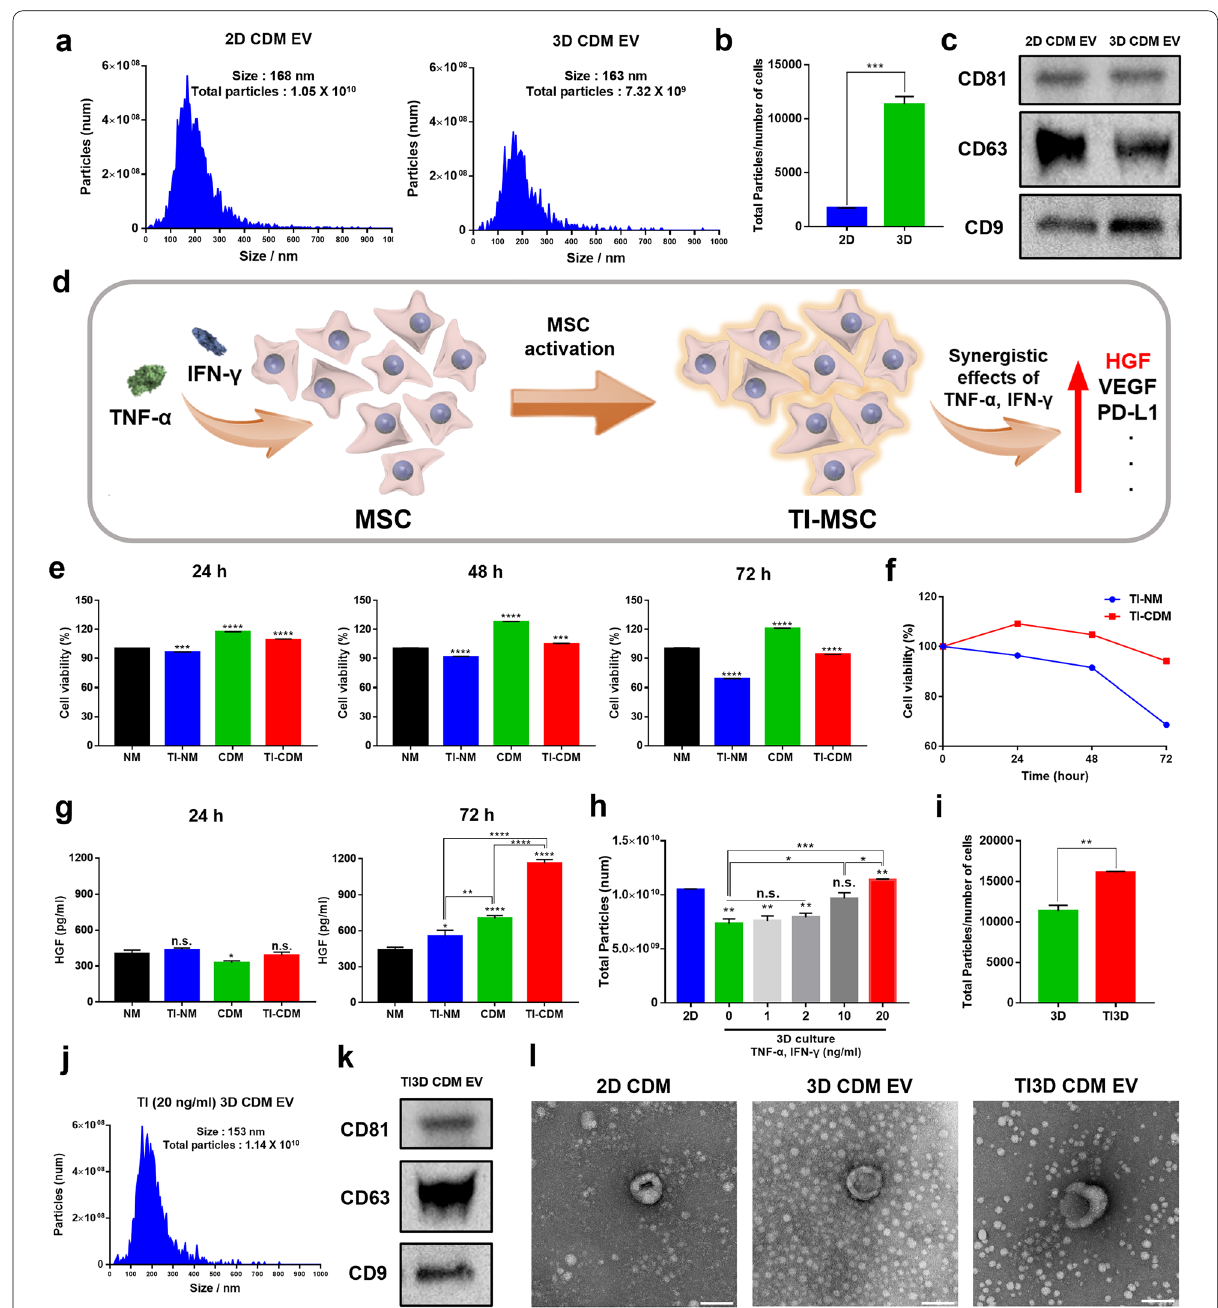
Fig. 2 Characterizations of EV from three different culture conditions. a ZetaView ® analysis for the size and number of total particles of 2D CDM EV and 3D CDM EV. b The number of particles per cell for 2D CDM EV and 3D CDM EV. c The Western blot analysis of 2D CDM EV and 3D CDM EV for representative surface markers of EVs. d The benefits of MSC activation using TNF‑α and IFN‑γ (TI) priming. e Time‑dependent cell viability with TI activation in NM and CDM (NM; Normal media, 10% fetal bovine serum supplemented ɑ ‑MEM, CDM; CellCor ™ CD MSC media). f Comparison of cell viabilities in TI‑activated hUCMSC in NM and CDM. g The expression level of HGF in culture media of hUCMSC. h The total number of particles derived from different concentrations of TI treatments for hUCMSC spheroids in CDM. i The number of particles per cell with and without TI priming in 3D culture. j The size and total number of particles for TI3D CDM EV were analyzed using ZetaView ® . k The Western blot analysis for representative surface markers of TI3D CDM EV. l The morphologies of EVs are characterized by TEM. Scale bars equal to 100 nm. (Values are presented as mean SD (n 3) and statistical significance was obtained with one‑way analysis of ANOVA with Tukey’s multiple comparison post‑test (* p < 0.05; ± = ** p < 0.01; *** p < 0.001; **** p <